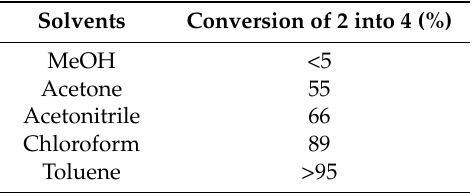
Table 1. Conversion of hydroperoxide 2 into hydroperoxide 4 determined by 1 H NMR after 48 h in various solvents at room temperature using an internal standard (see Supporting Information Figures S11–S13).